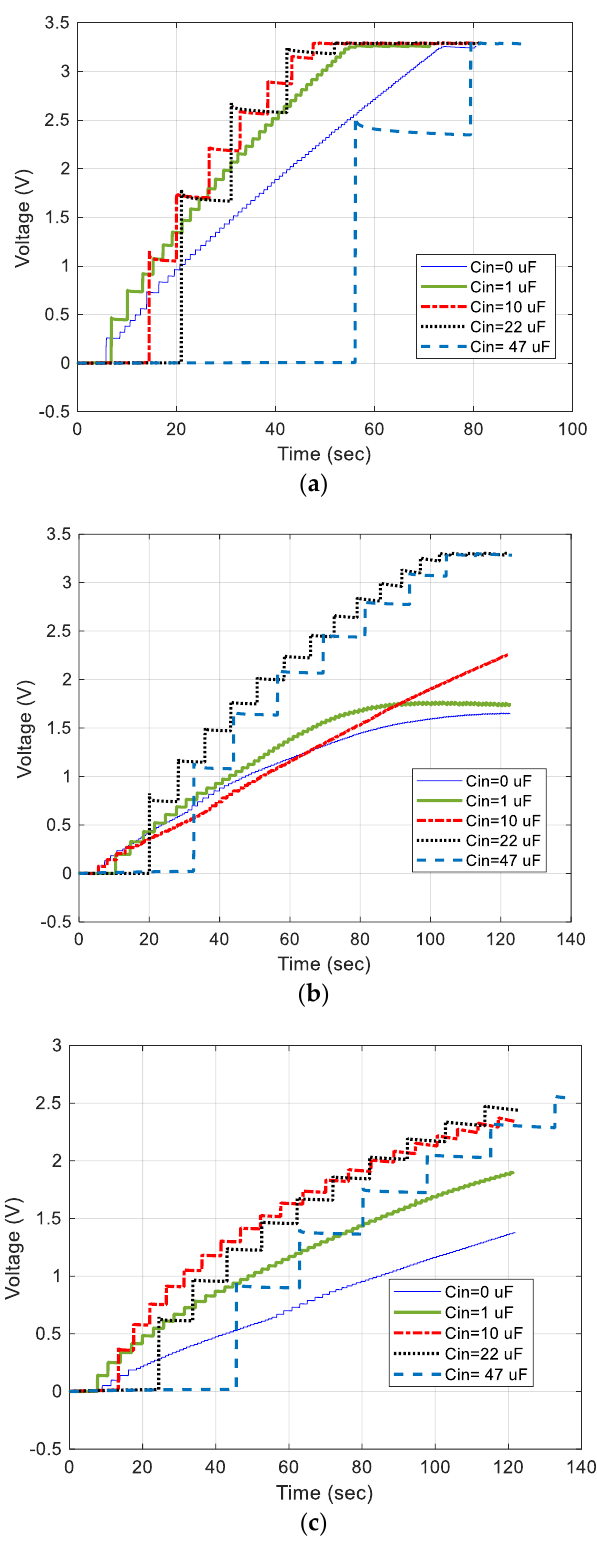
Figure 9. The output voltage of LTC3588 versus time for different values of C in and for open circuit; f = 2.88 Hz ( a ) C out = 47 µF, ( b ) C out =220 µF, and ( c ) C ou t = 330 µF.